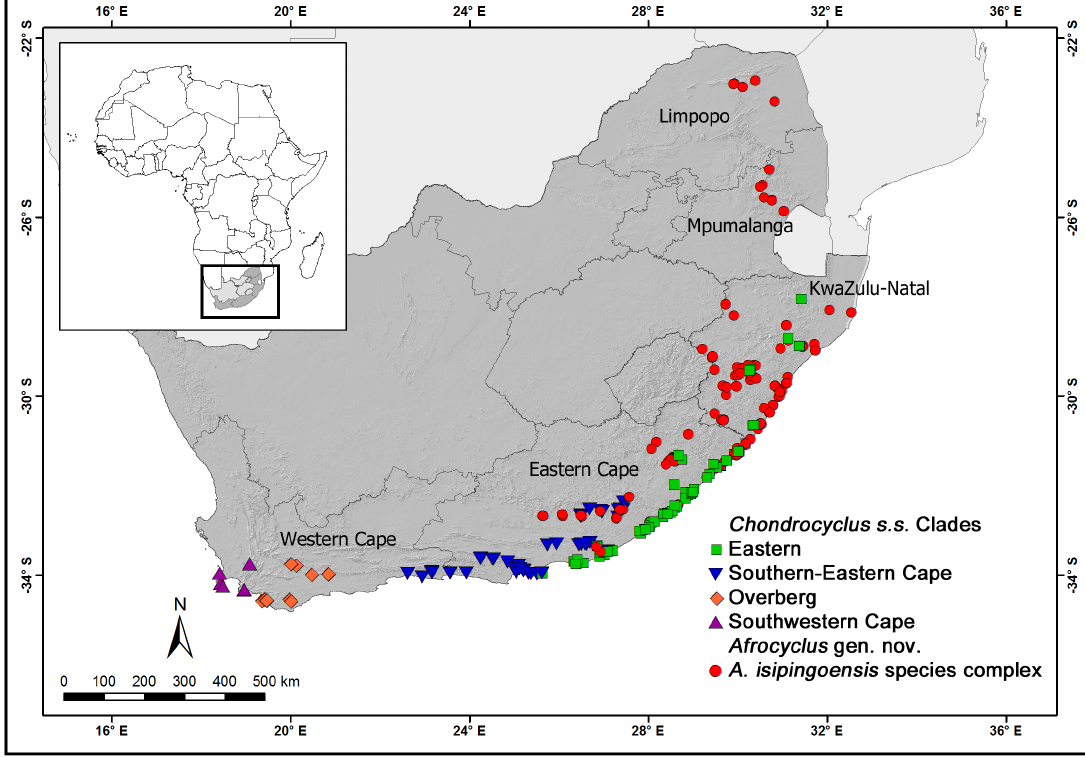
Fig. 2. Map of South Africa showing distribution of the five major clades of Chondrocyclus s.l. Ancey, 1898. Provinces with records of Chondrocyclus